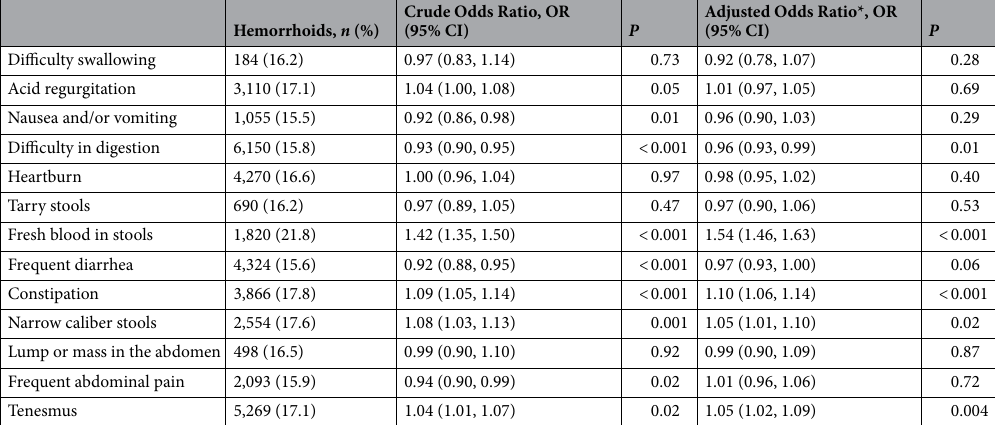
Table 4. Association between self-reported gastrointestinal symptoms and the prevalence of hemorrhoidal disease. * Adjusted for age (20–29, 30–39, 40–49, 50–59, and 60–70 years), sex, year of visit, center, education (≤ 12 and > 12 years), physical activity (low, moderate, and high), smoking (never, former, and current), daily alcohol intake (none, < 5 g/day, 5 to < 20 g/day, and ≥ 20 g/day), BMI category (underweight, normal, overweight, and obese), and presence of diabetes, hypertension, and